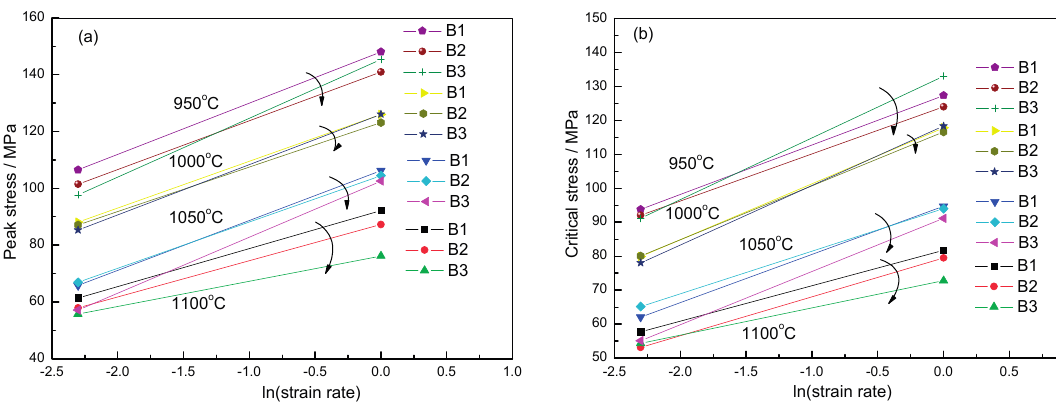
Figure 12. Relationship between peak, critical stress and the logarithm of the strain rate ( a ) peak stress; ( b ) critical stress.